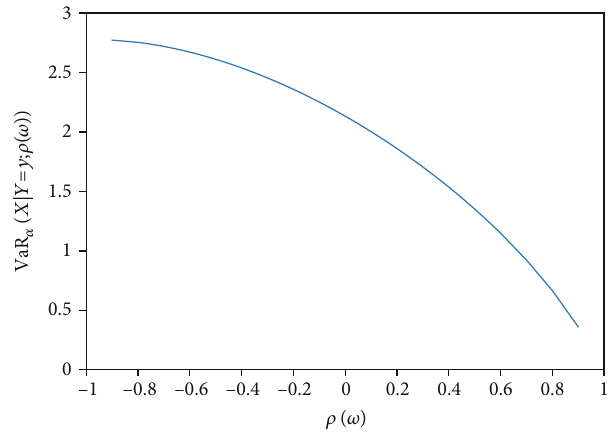
Figure 6: The estimative VaR forecast of t distributed data against dependence measure ρ ð ω Þ ; the degrees of freedom are set κ = κ = κ X Y